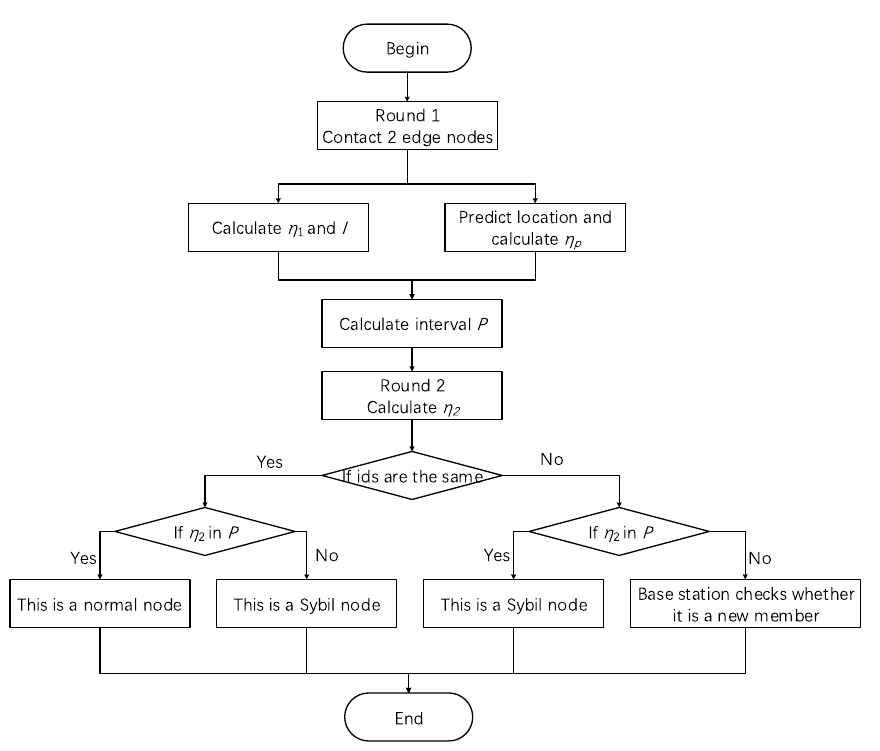
Fig. 2 Flowchart of the proposed